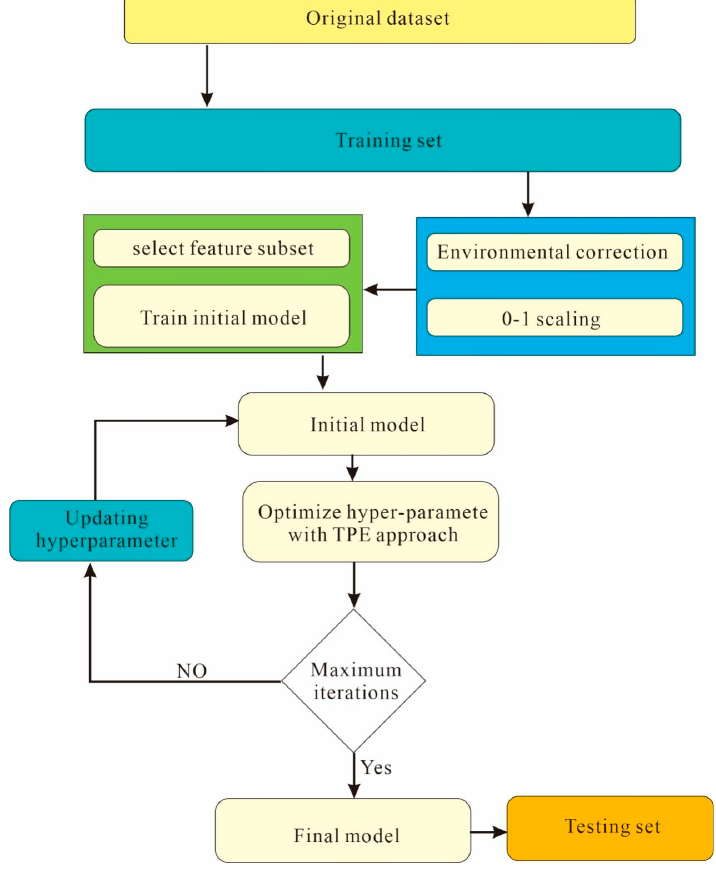
Figure 3. Establishment process of CBM gas content prediction model.